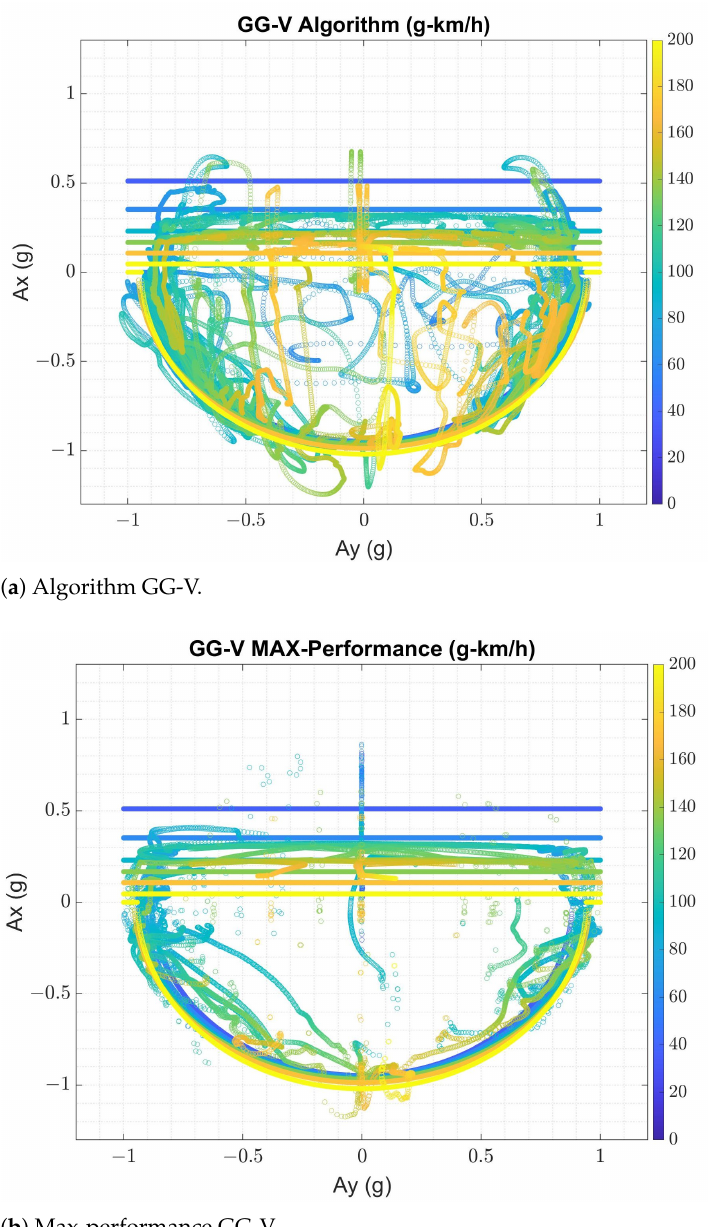
Figure 7. Acceleration performance